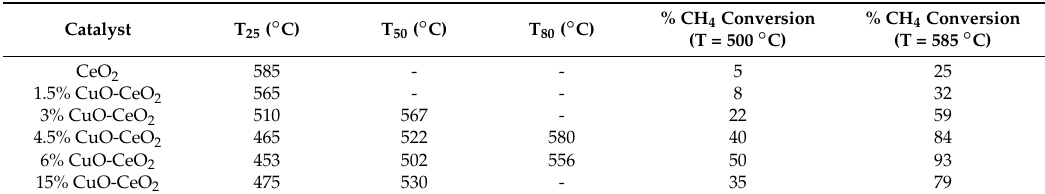
Figure 6. Light-off curves of CH 4 oxidation measured under 78,000 cm 3 g −1 h −1 WHSV for CeO 2 and different CuO-CeO 2 catalysts prepared by solution combustion synthesis (SCS). Table 1. List of different catalysts prepared by SCS and their corresponding T 25 , T 50 , T 80 and % CH 4 conversion at two different temperatures of 500 °C and 585 °C.